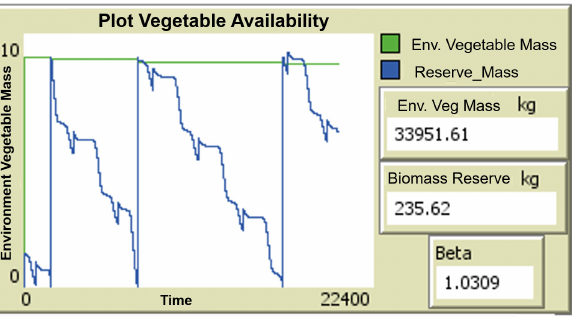
Figure 20. Biomass consumption indicators interface implemented in Netlogo.